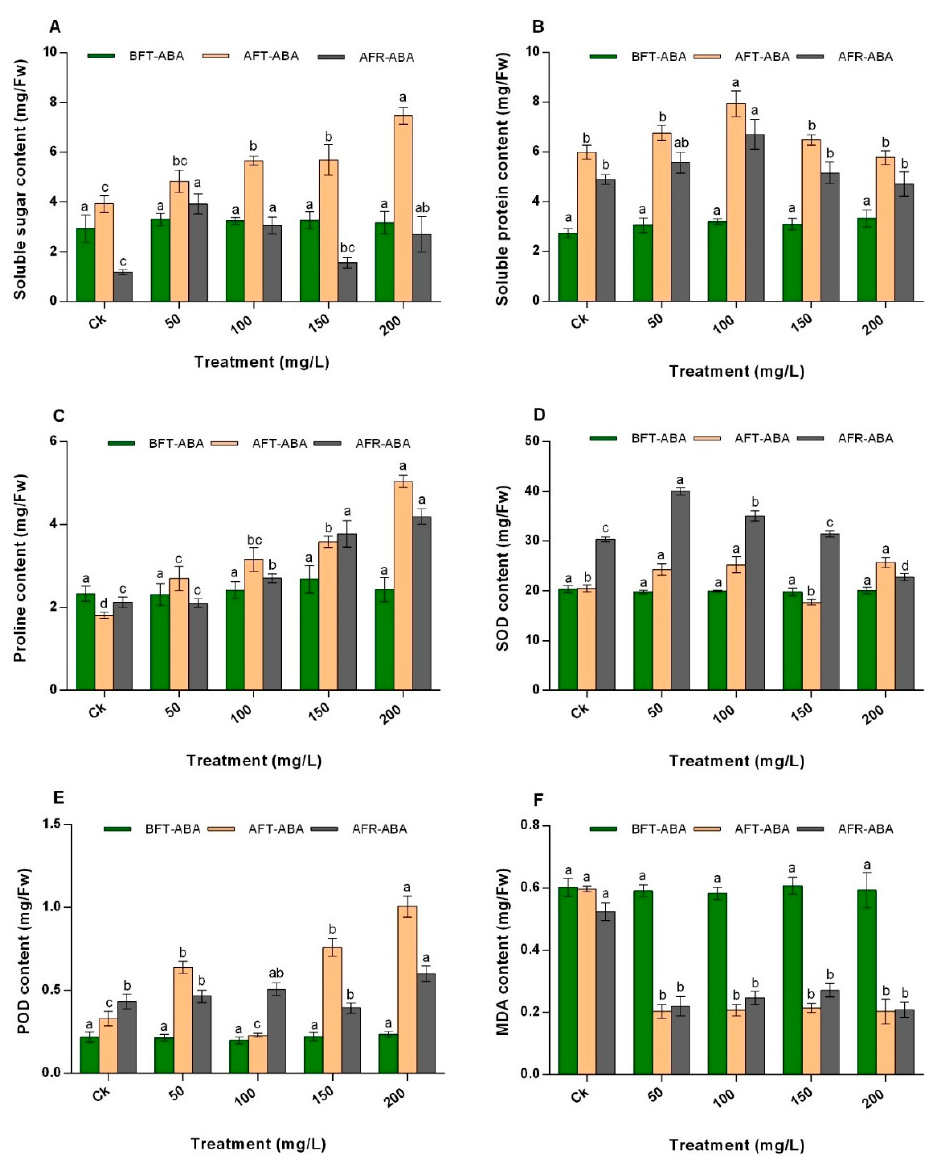
Figure 2. Effect of ABA on the ( A ) soluble sugar content, ( B ) soluble protein content, ( C ) proline content, ( D ) SOD content, ( E ) POD content, and ( F ) MDA content of N. tangutorum . The values represent the mean of three replicates determinations. The error bars represent standard deviations. Bars with the same letter are not significantly ( p > 0.05) different.